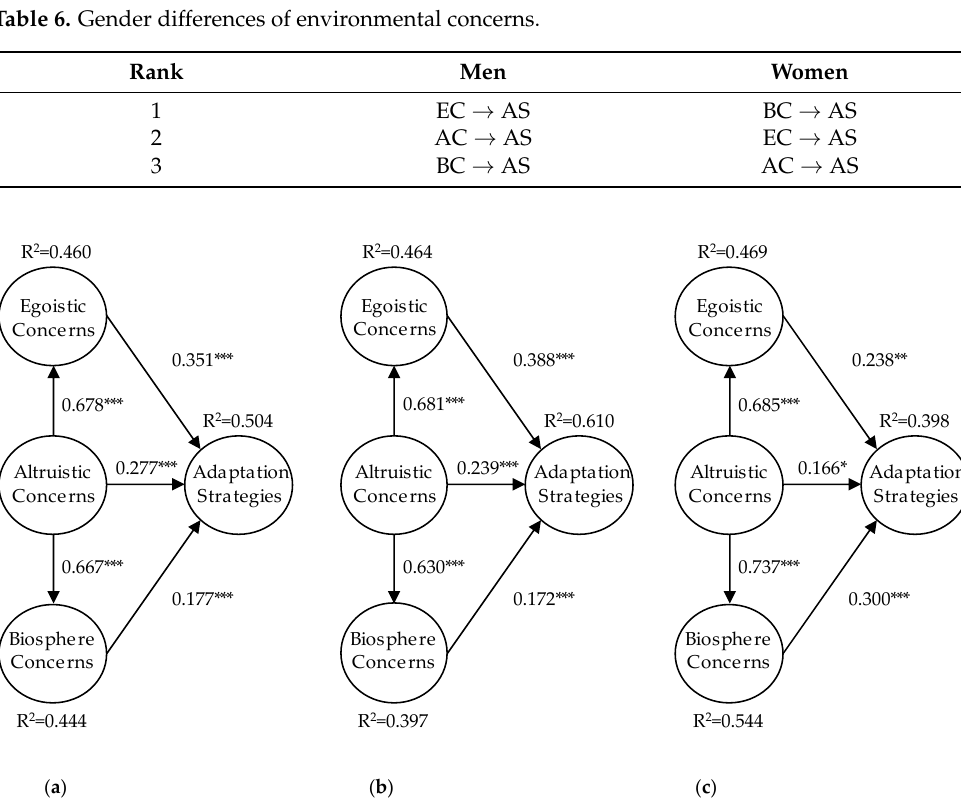
Figure 4. Path analysis results for posts by ( a ) both genders, ( b ) men, and ( c ) women. Notes: *: p < 0.050; **: p < 0.010; ***: p < 0.001.